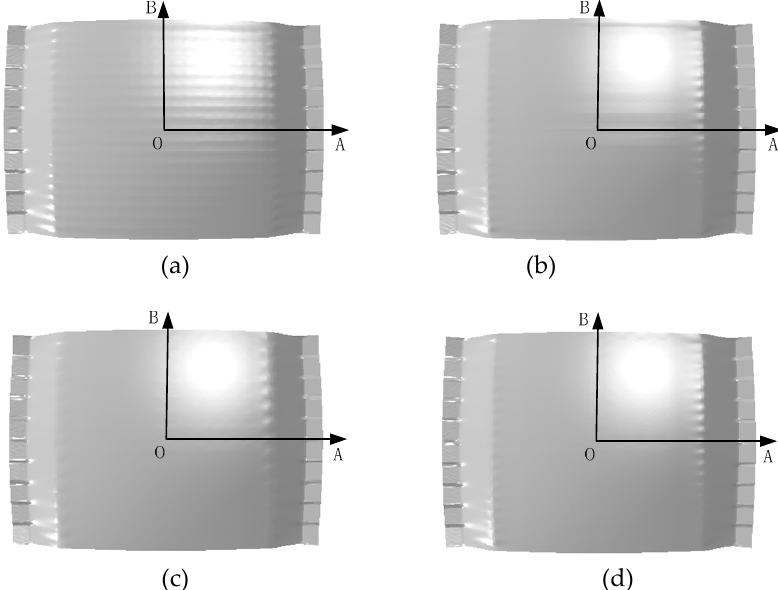
Figure 6. Light maps of the formed parts: ( a ) formed by fixed ball heads with conventional arrangement (FBHC); ( b ) formed by swinging ball heads with conventional arrangement (SBHC); ( c ) formed by swinging ball heads with declining staggered arrangement (SBHDS); ( d ) formed by swinging ball heads with parallel staggered arrangement (SBHPS).